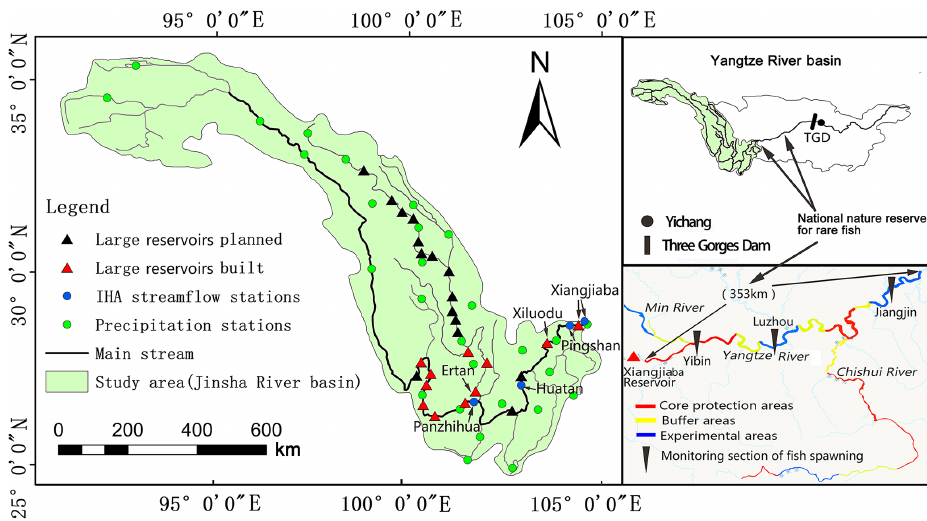
Figure 1. Generalized map of study region. TGD: Three Gorges Dam. Table 1. Large reservoirs built in the Jinsha River basin.